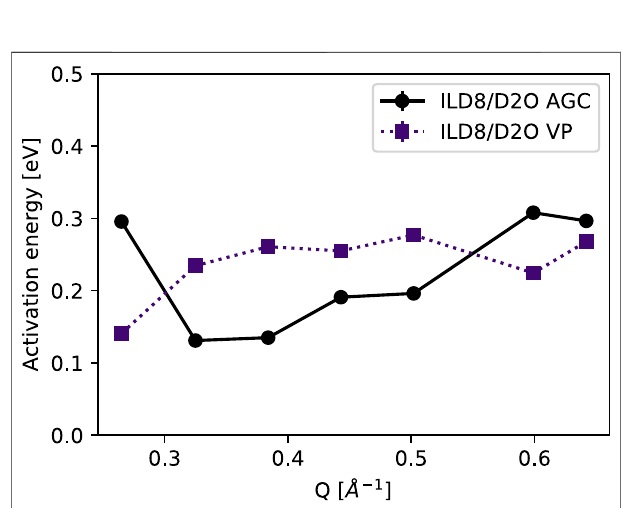
FIGURE 7 | Activation energy as a function of scattering vector Q for the samples ILD8/D2O, where the higher temperature could be exploited. The statistical errors from the variance of the data are 0.08 and 0.05 eV for AGC and VP samples respectively.